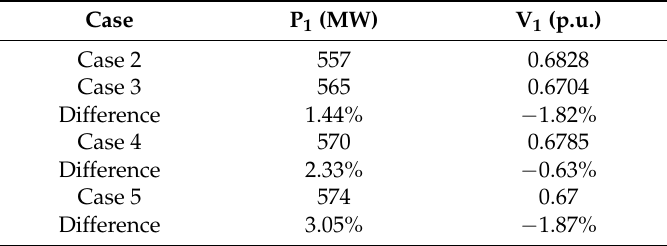
Table 11. Maximum power transmission under spatial